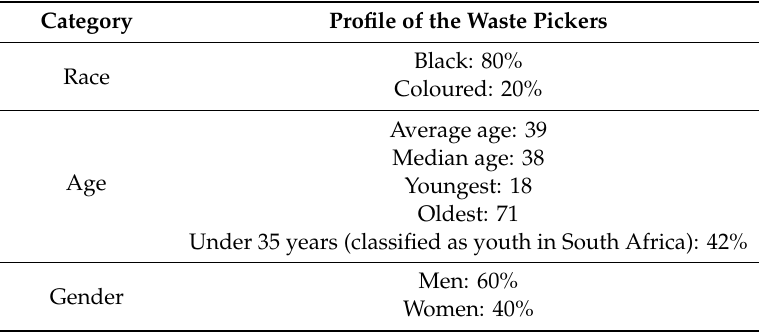
Table 3. Profile of the waste pickers